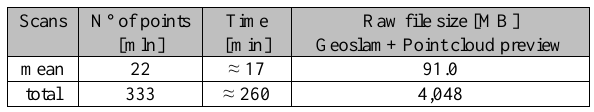
Table 6. MMS scans specification.